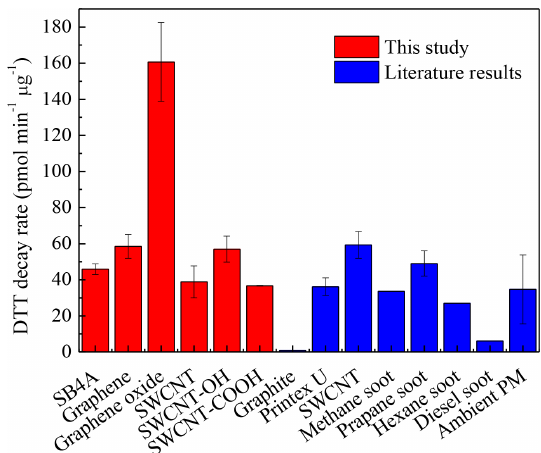
Figure 1. DTT decay rates of several black carbon materials com- pared with literature results (Li et al., 2013, 2015; Charrier and Anastasio, 2012; Q. Liu et al., 2014a; Liu et al., 2015; Holder et al., 2012; Antinolo et al.,